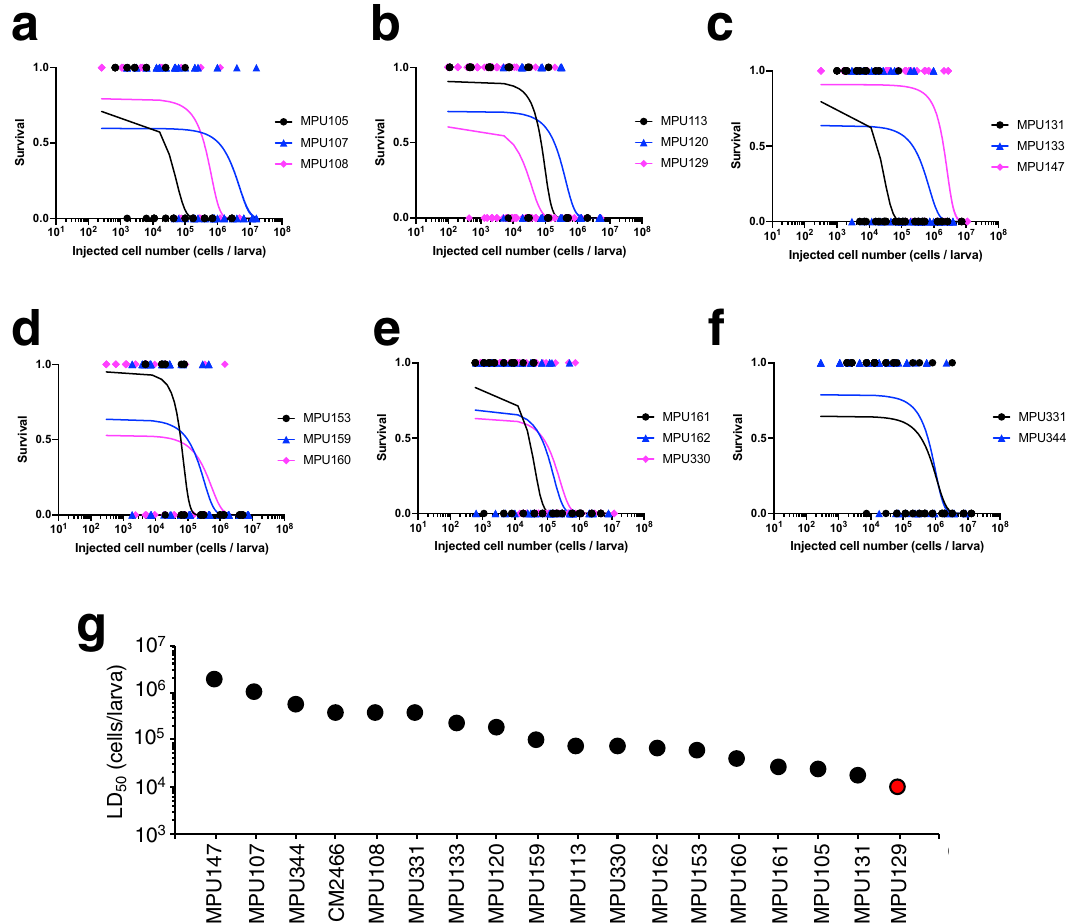
Figure 1. Comparison of pathogenicity of T. asahii strains against silkworms. ( a–f ) The number of surviving silkworms under a rearing condition at 37 °C was determined 48 h after administration of the fungal cells (1 × 10 2 to 2 × 10 7 cells/larva) into the hemolymph of silkworms. Survived and dead silkworms are indicated as 1 and 0, respectively. n = 4/group. The curves were drawn from the combined data of 2–6 independent experiments by a simple logistic regression model. ( g ) LD 50 values of T. asahii strains. Data for JCMM2466 are cited from Matsumoto et al. 20